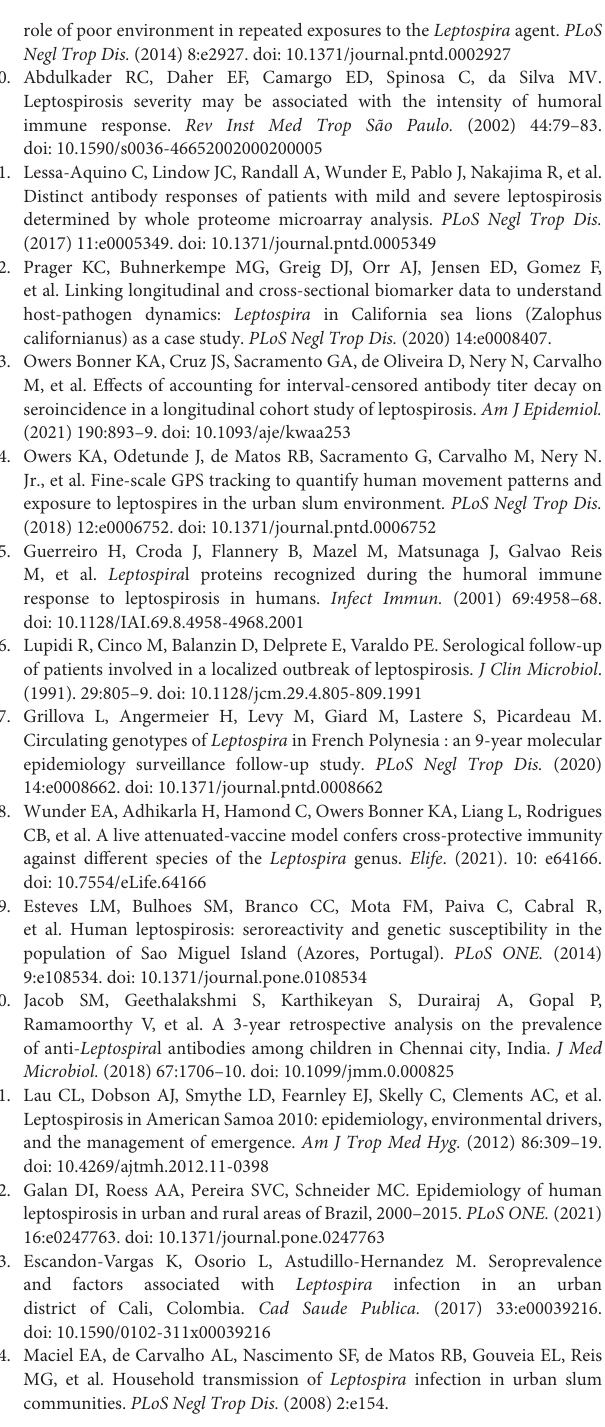
Supplementary Table S1 | Anti-leptospira antibody titers distributed by classification and collection period.